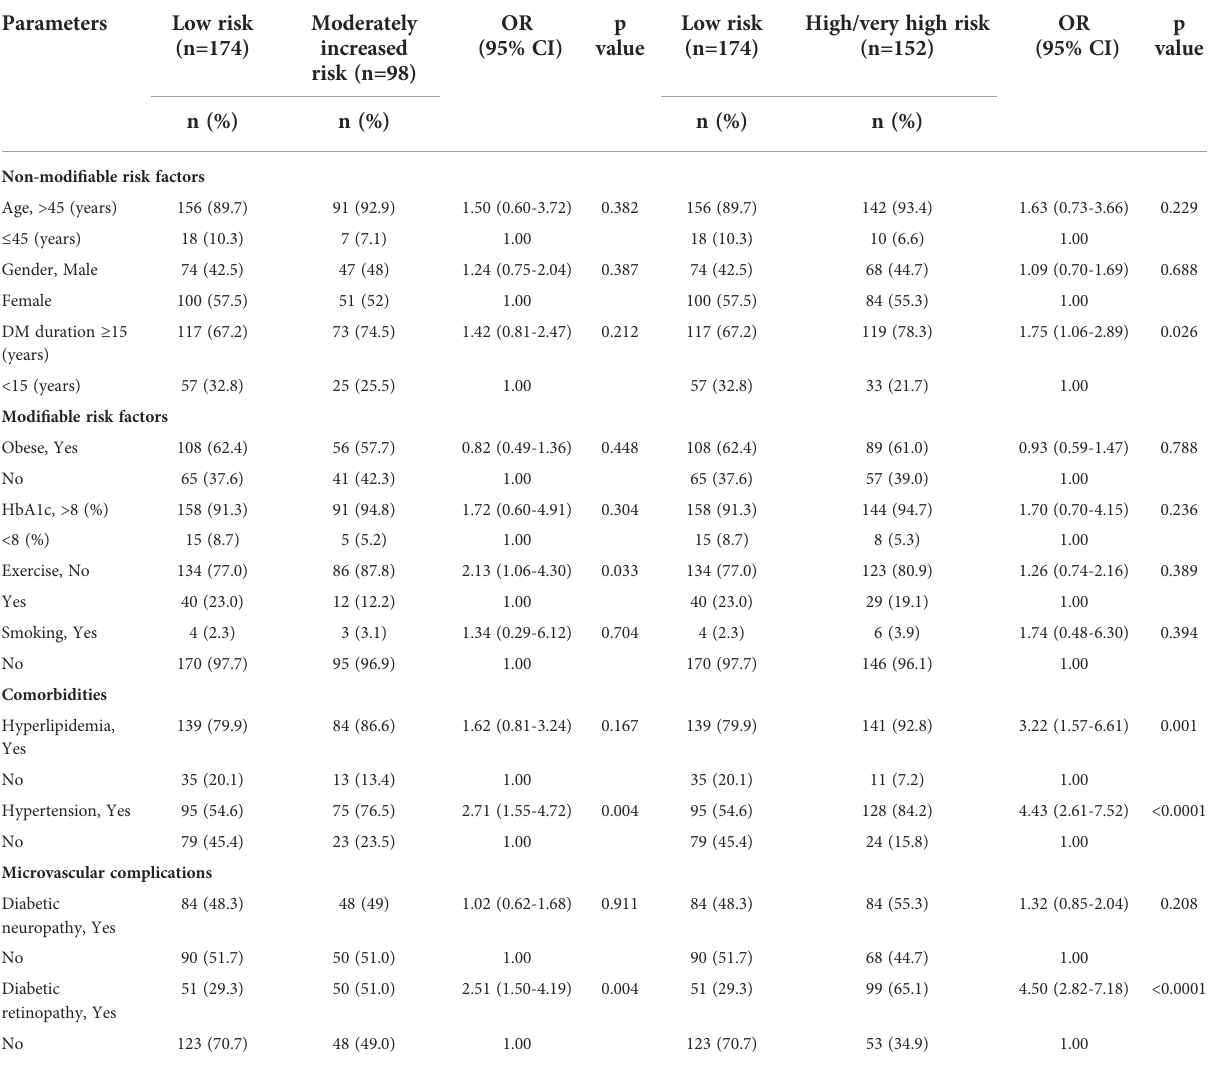
TABLE 2 Odds ratios of risk factors associated with the severity of kidney disease among patients with type 2 diabetes. Parameters Low risk Moderately (n=174) increased risk